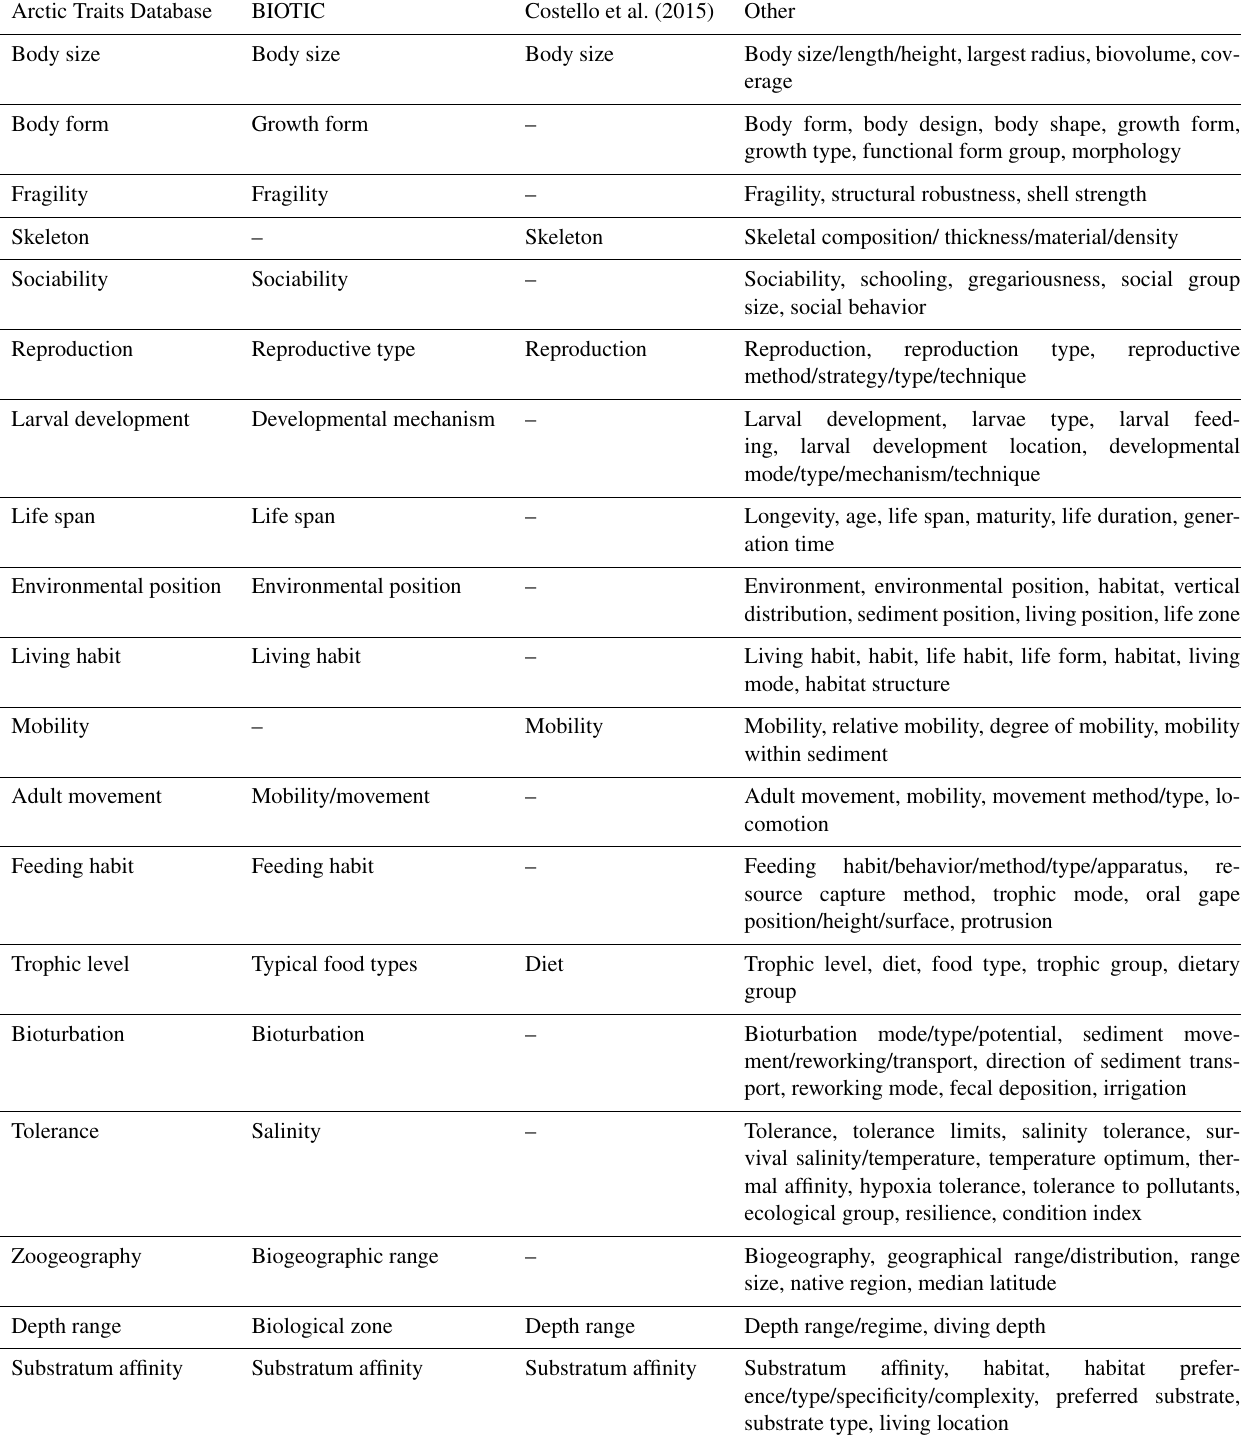
Table 2. Trait terminology as used in the Arctic Traits Database, BIOTIC, Costello et al. (2015) and in other marine trait-based studies (i.e., studies reviewed in Degen et al., 2018, list non-exhaustive; see Appendix 1 of Degen et al., 2018 for total trait list and corresponding literature references). Be aware that the Arctic Traits Database and BIOTIC only consider benthic taxa, while Costello et al. (2015) and the studies summarized in “Other” cover all marine